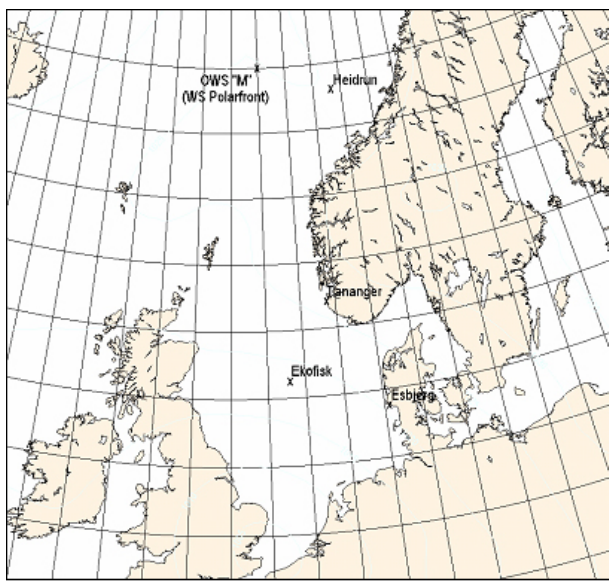
Figure 1. Location of the Ekofisk field.